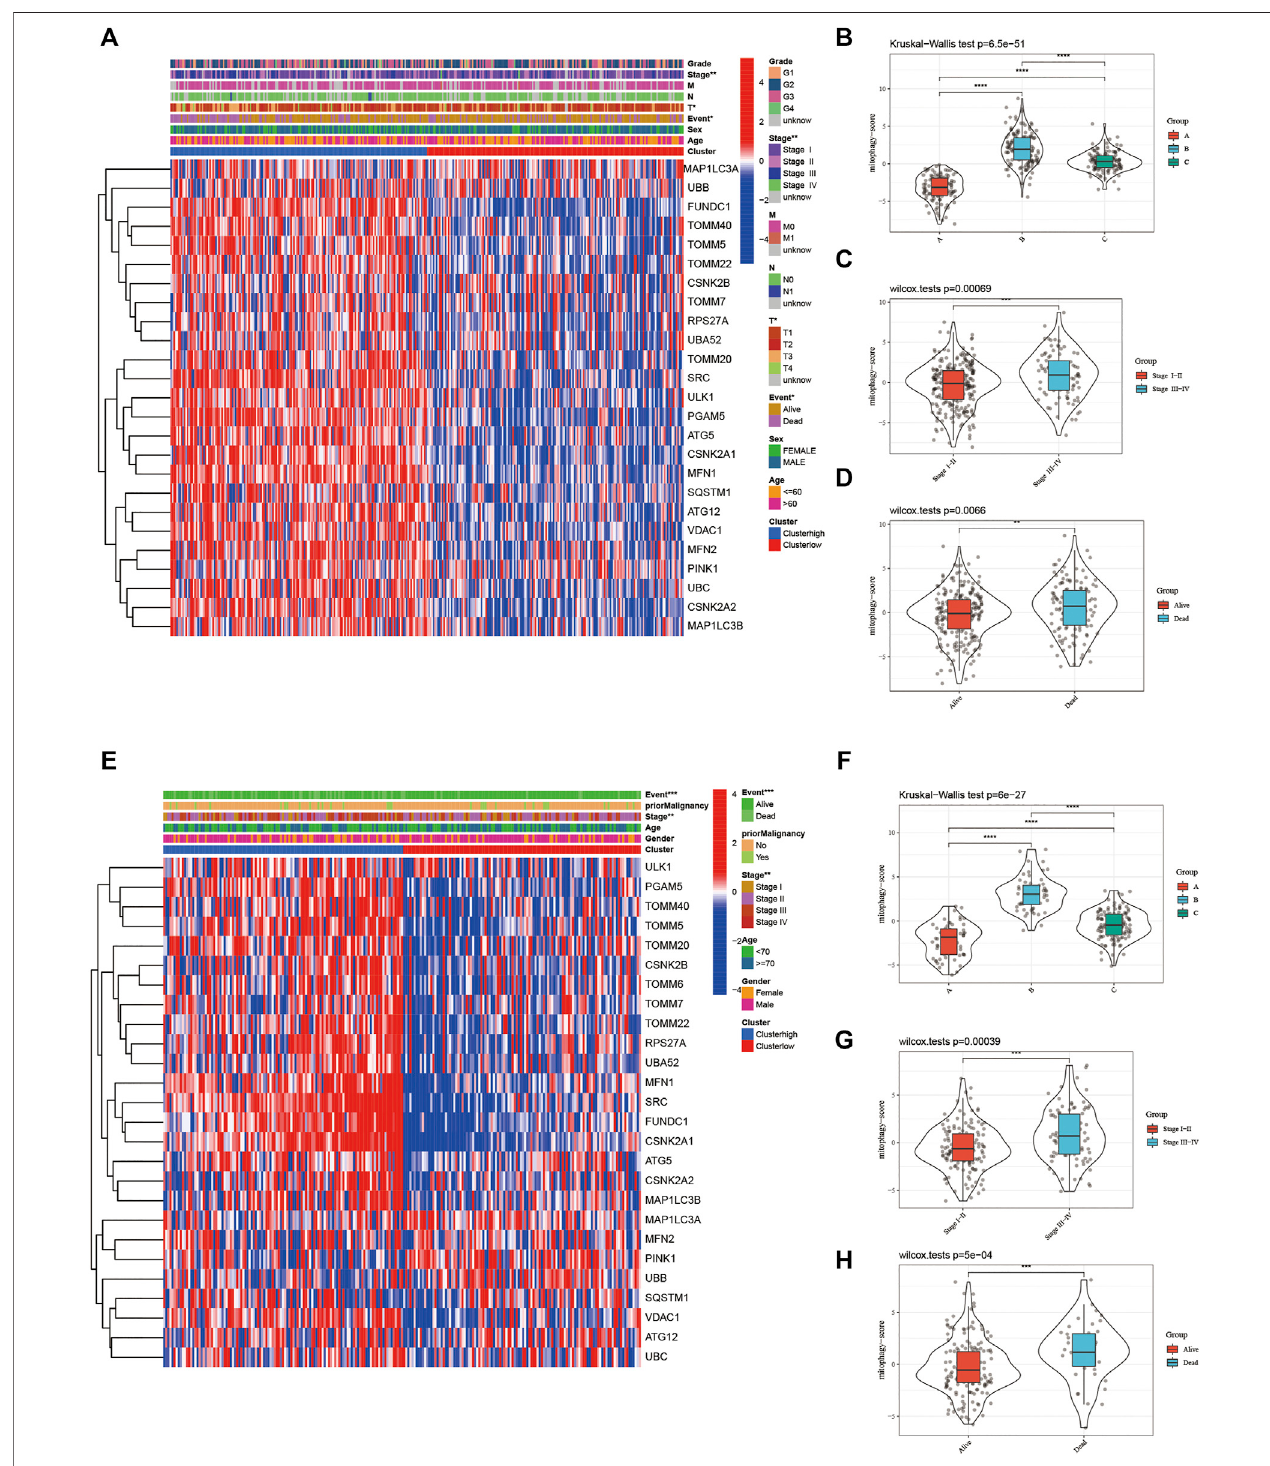
FIGURE 6 | (A) The heatmap of gene expression in the high-risk group versus low-risk group for the mitophagy regulators in TCGA LIHC cohort. Violin plot of differentmitophagyscoresbetweendifferentmitophagysubtypes (B) ,stages( C) andsurvivalstatus (D) ofTCGALIHCcohort (E) Theheatmapofgeneexpressioninthe high-risk group versus low-risk group for the mitophagy regulators in ICGC cohort. Violin plot of different mitophagyscores between different mitophagy subtypes (F) , stages (G) and survival status (H) of ICGC cohort. The asterisks represented the statistical p value (* p < 0.05; ** p < 0.01; *** p < 0.001; **** p < 0.0001).